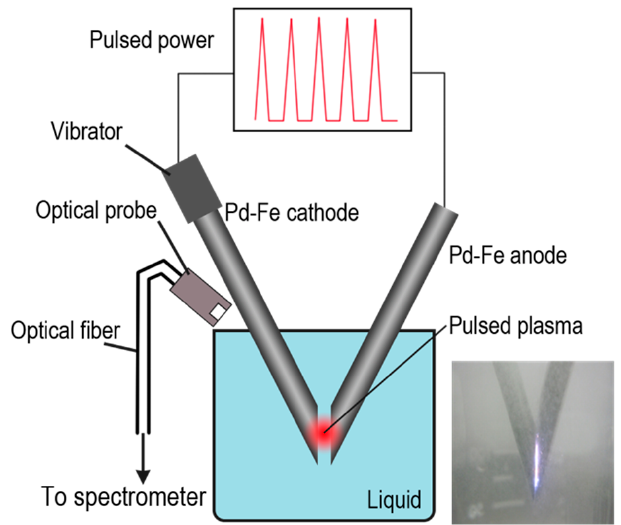
Figure 1. Schematic of pulsed-plasma-in-liquid method.